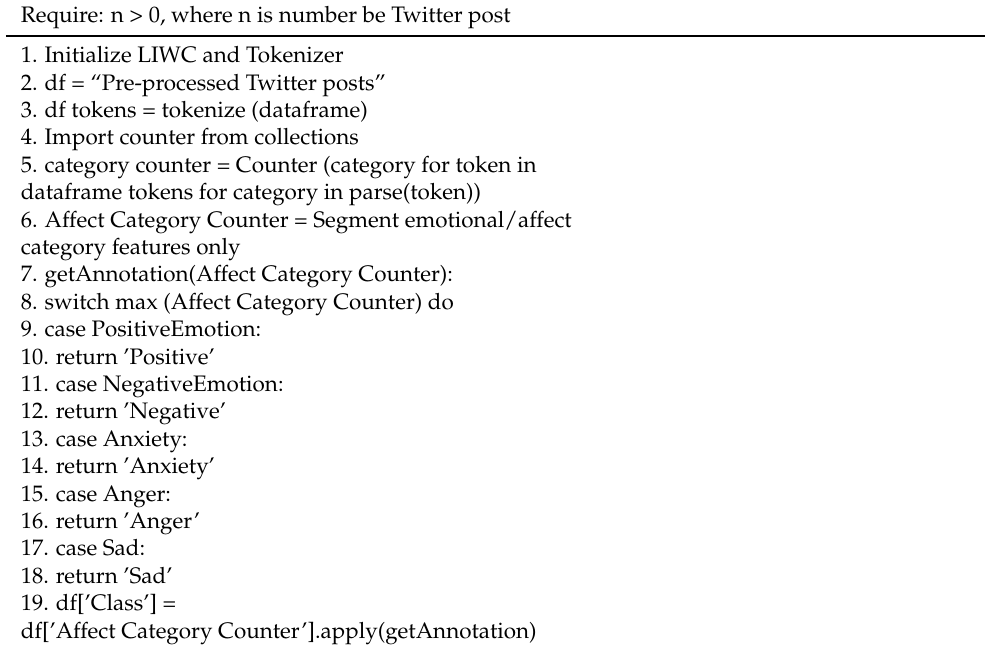
Table 4. Pseudocode 2—Emotion Detection and Annotation.